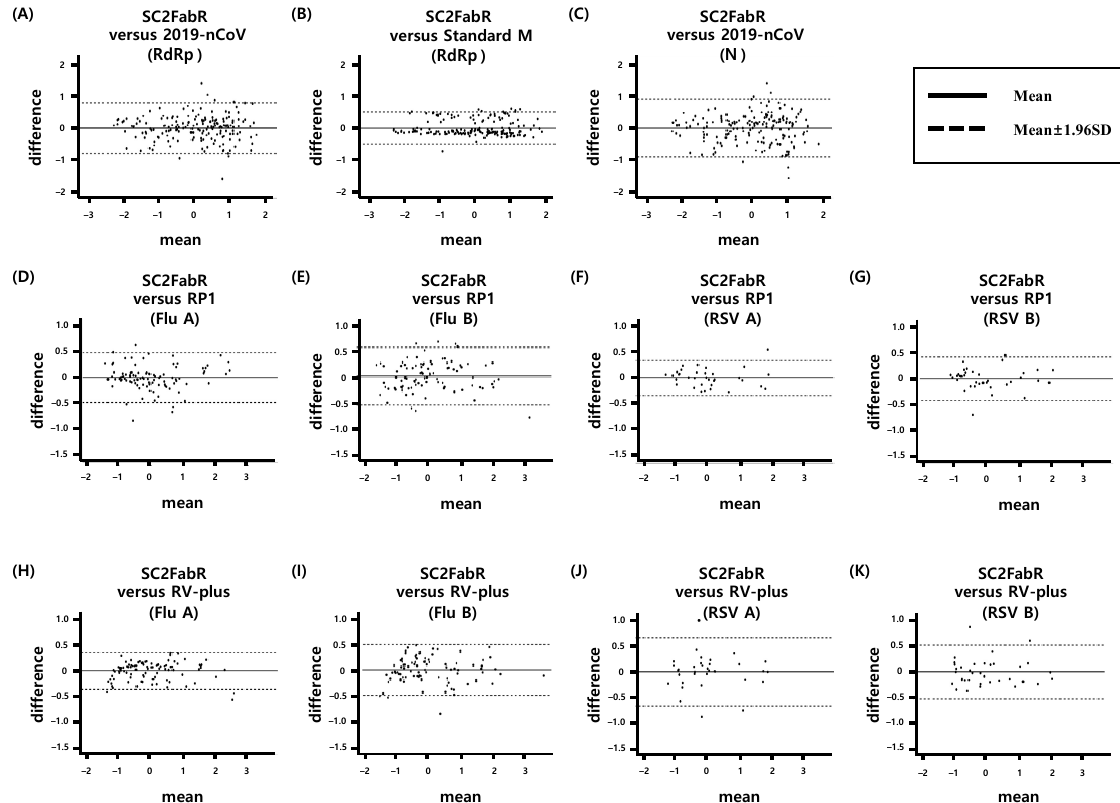
Figure 5. Bland-Altman analysis of the quantitative data from three molecular assays for SARS-CoV-2, Flu, and RSV. The analysis was performed using matched positive samples from all assays to compare the transformed Ct values from the SC2FabR and well-established assays. The mean Ct values are plotted on the x-axis, while the Ct difference between the two platforms for each sample are plotted on the y-axis. The mean and 1.96 SD border are shown. RdRp gene, gene encoding the RNA-dependent RNA polymerase of SARS-CoV-2 ( A , B ); N , gene encoding the nucleocapsid protein of SARS-CoV-2 ( C ); Flu A, influenza A virus ( D , H ); Flu B, influenza B virus ( E , I ); RSV A, respiratory syncytial virus A ( F , J ); RSV B, respiratory syncytial virus B ( G , K ).